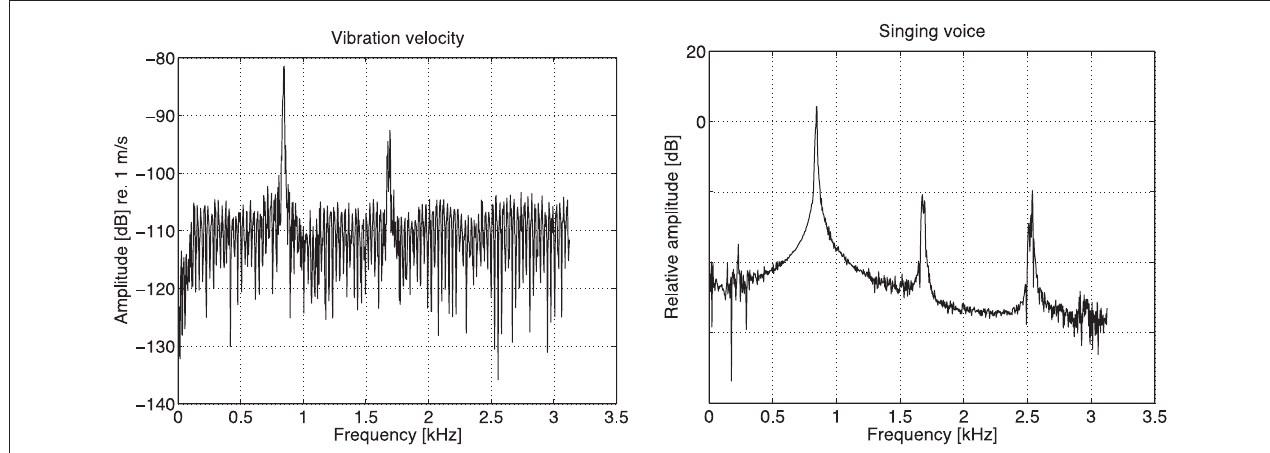
FIGURE 5 | Log spectra of forehead vibration velocity measured by scanning LDV at one point (left) and singing voice measured by microphone (right) for vowel /a/ of Singer A. Vibration velocity units are m/s in dB.